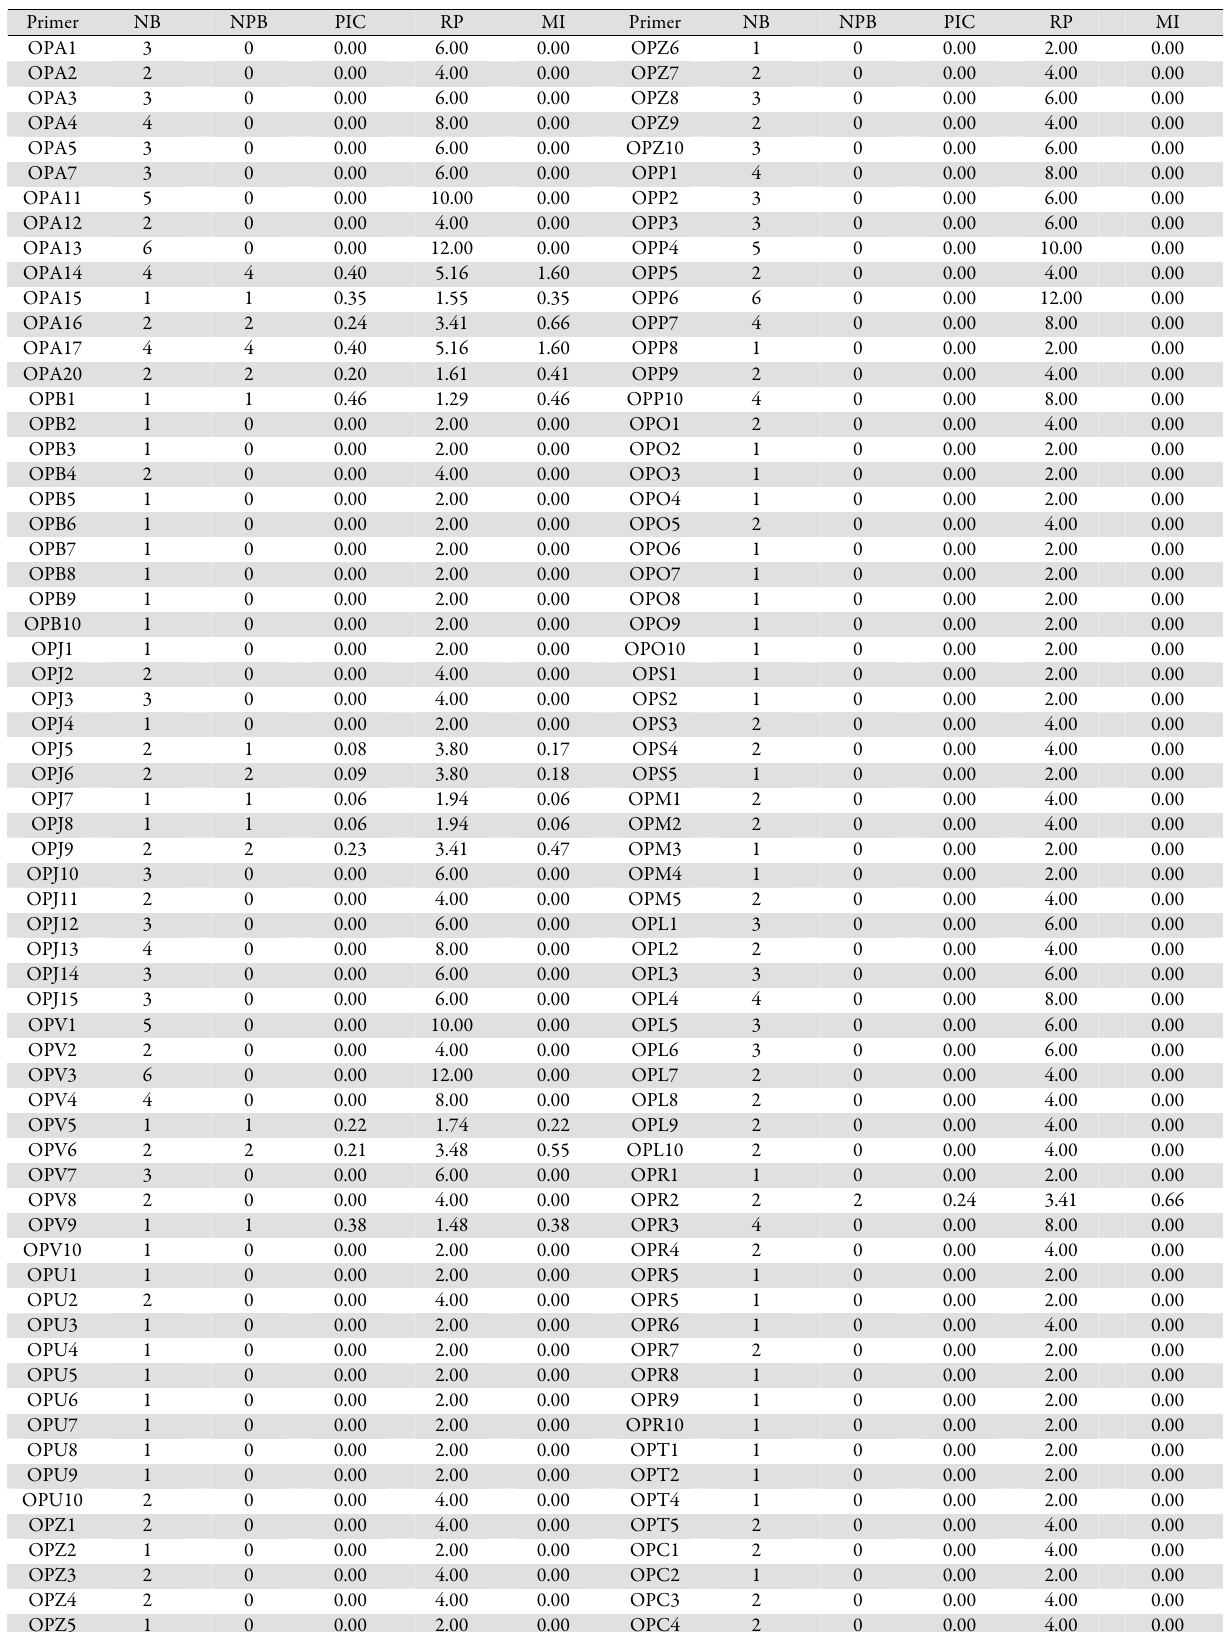
Table 1. Polymorphic profile of 128 RAPD primers across 31 selections of